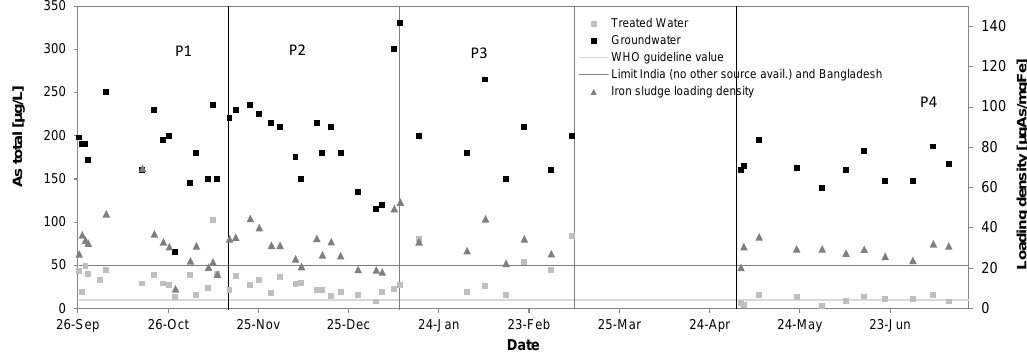
Figure 10. Arsenic removal performance of the Kalyani pilot system, September 2016–July 2017.